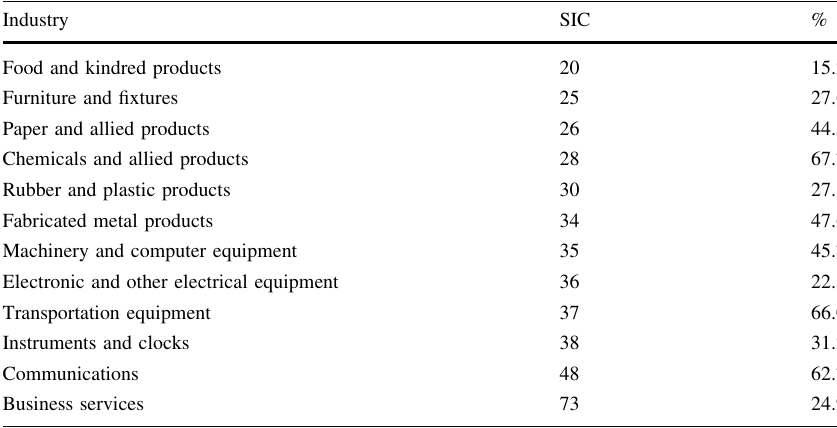
Table 4 Percentage of CHRO presence by industry